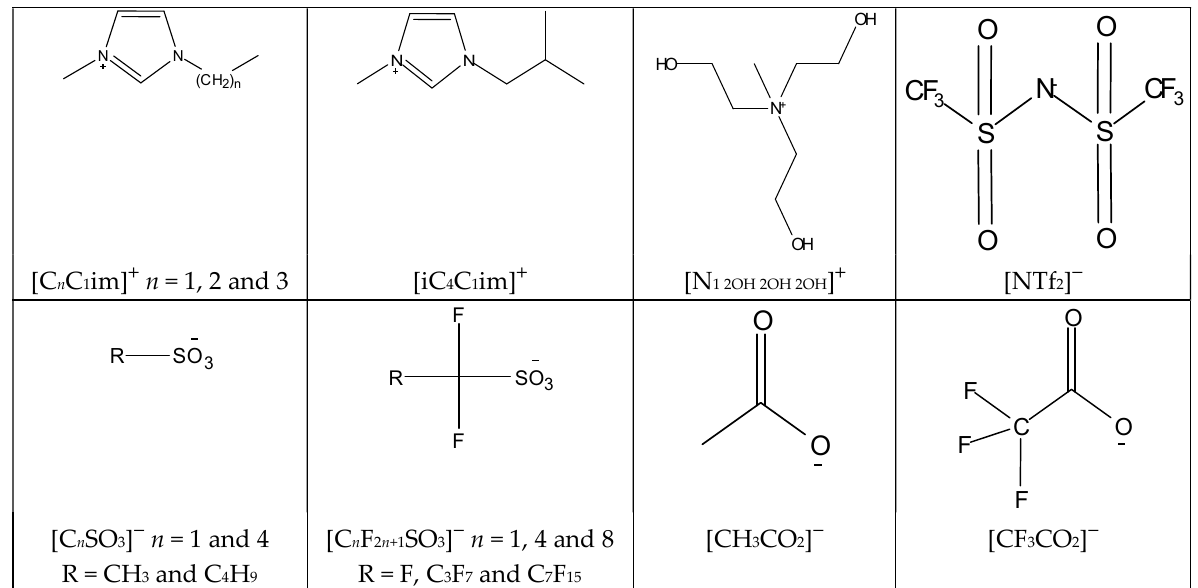
Chart 1. Molecular structure and acronyms of the ions composing the ionic liquids studied in this work.